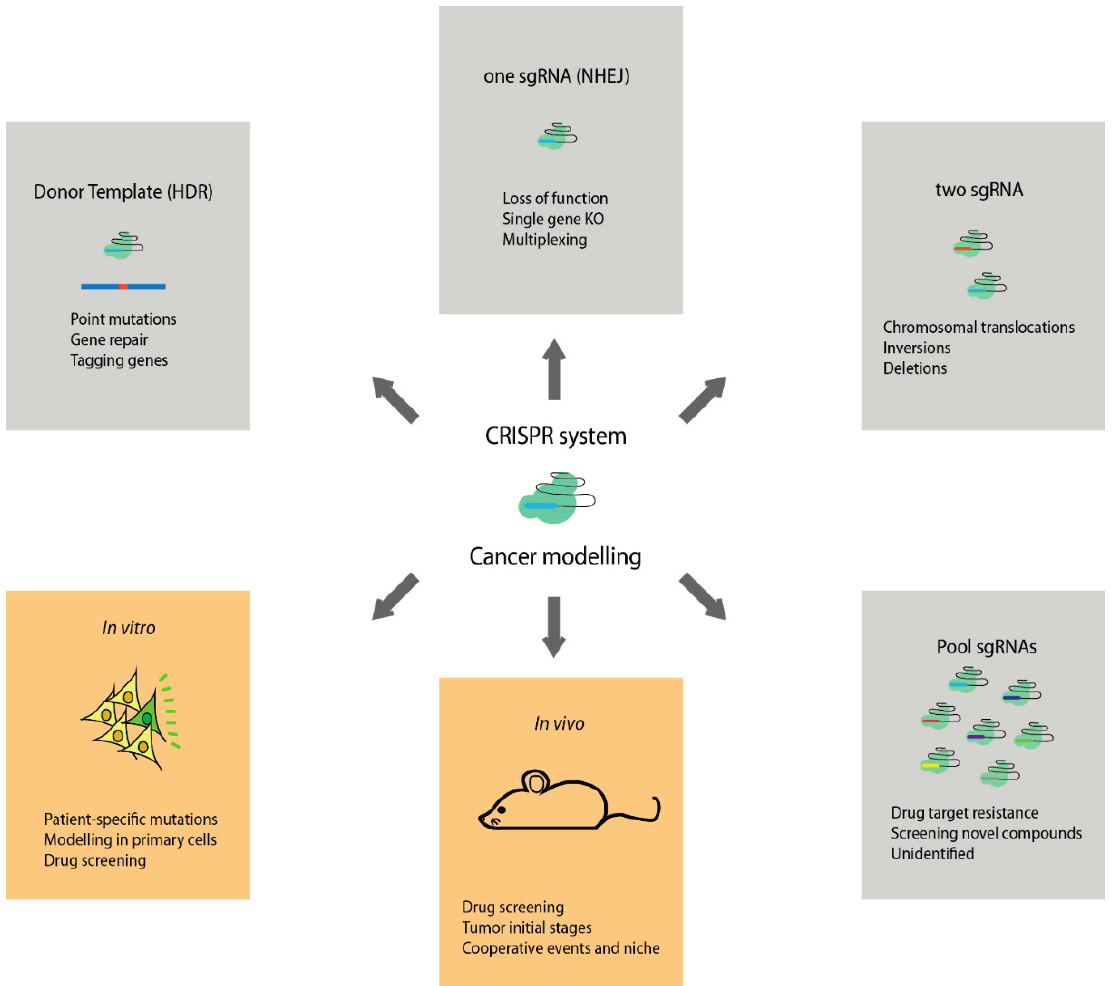
Figure 1. Types of genome-engineering CRISPR-Cas9 system applications to study cancer. HDR: homology-directed repair; sgRNA: small guide RNA; NHEJ: non-homologous end